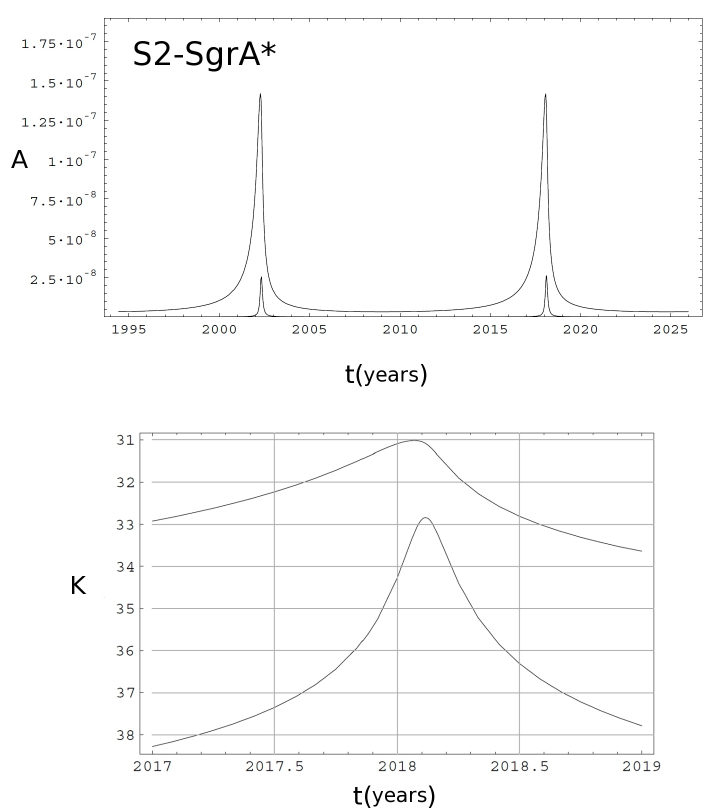
Figure 10. Upper panel: amplification as a function of time for the primary (upper curve) and secondary (lower curve) retro-lensing images of the S2 star by the black hole in the Galaxy center. Lower panel: light curve in K-band magnitude of the two retro-lensing images (adapted from [106]). The standard interstellar absorption coefficient towards the Galaxy center has been